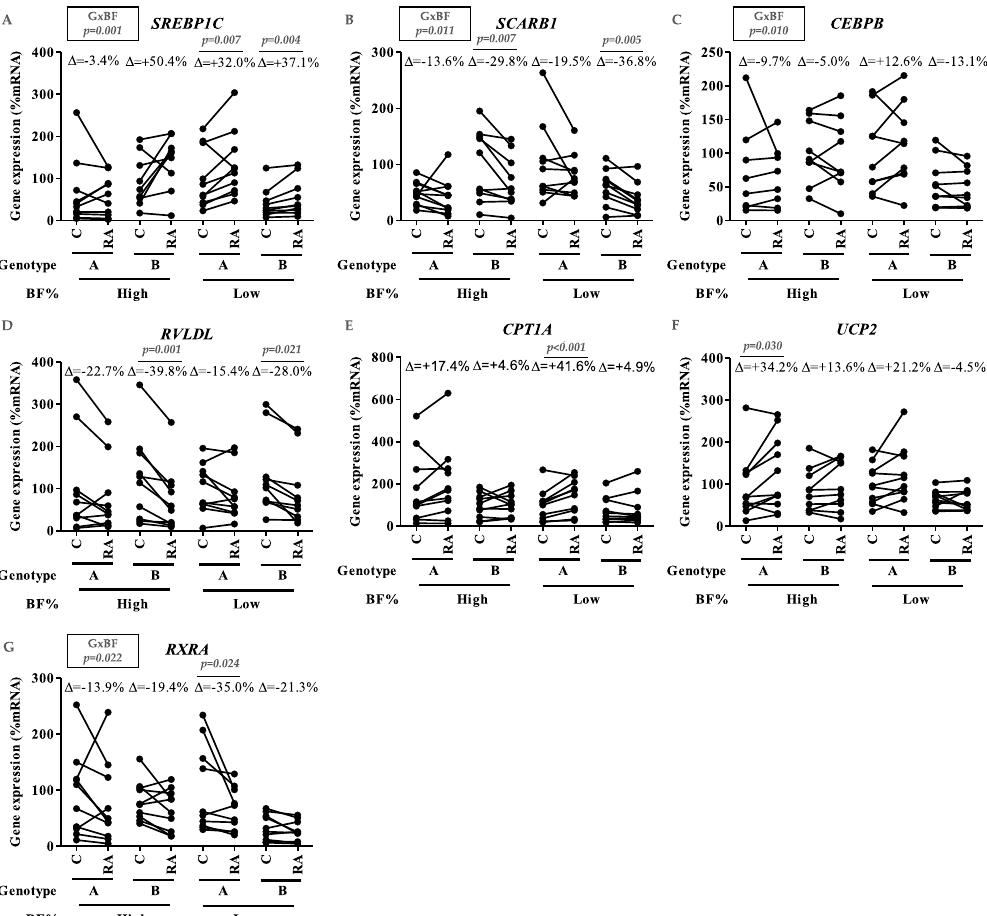
Figure 3. Effect of all-trans retinoic acid treatment on mRNA expression in Peripheral Blood Mononuclear Cells of Genotype (A/B) and BF% level (High/Low). Effect of all-trans retinoic acid (RA, 1µM) treatment on mRNA expression in Peripheral Blood Mononuclear Cells (PBMCs) of subjects according to genotype (A/B) and BF% level (High/Low) groups. Data correspond to mRNA levels of ( A ) Sterol Response Element Binding Protein 1c (SREBP1C), ( B ) Scavenger Receptor Class B Member 1 (SCARB1), ( C ) CCAAT/enhancer-binding protein beta (CEBPB), ( D ) Very Low Density Lipoprotein Receptor (RVLDL), ( E ) Carnitine palmitoyltransferase I alpha (CPT1A), ( F ) Uncoupling Protein 2 (UCP2), and ( G ) Retinol-X Receptor α (RXRA). The % increase (Δ) was obtained by the difference between the mean of the gene expression in RA-treated cells and the mean of gene expression under baseline conditions (C) in each experimental group. Statistical assessment of the effect of treatment on each experimental group was estimated using a paired t-test. Genotype–BF% interaction regarding the effect of treatment was assessed using repeated measures ANOVA (GxBF, p < 0.05).